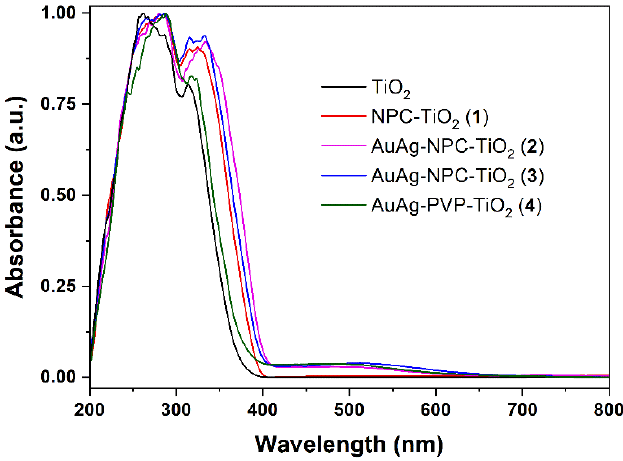
Figure 5. Solid UV-Vis spectra for pristine TiO 2 and nanohybrids 1–4